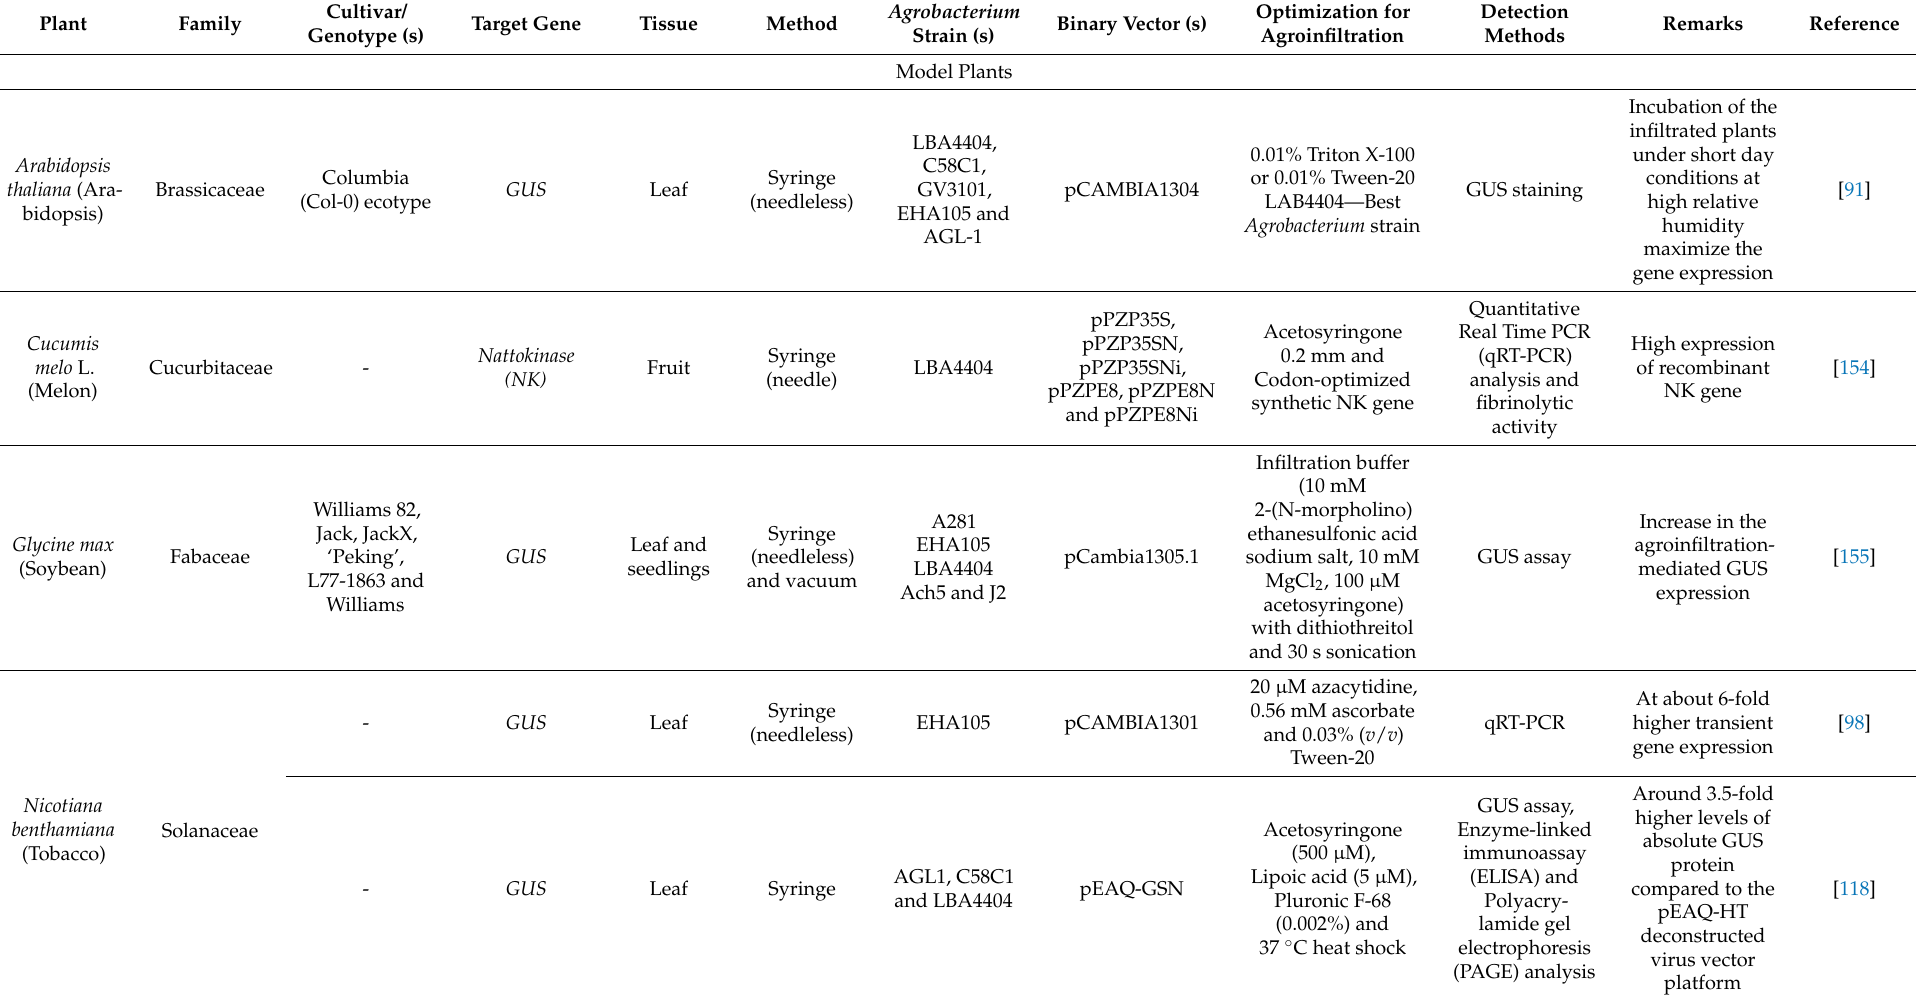
Table 1. Optimization of various parameters for agroinfiltration in